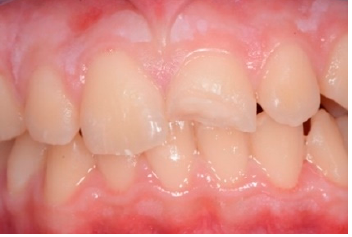
Figure 6. Intraoral photographic documentation.